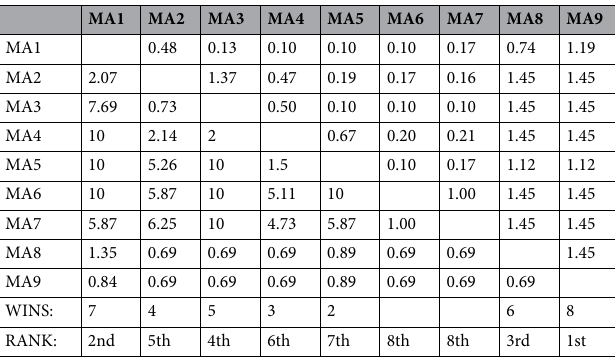
Table 2. Condorcet comparison of the alternatives.